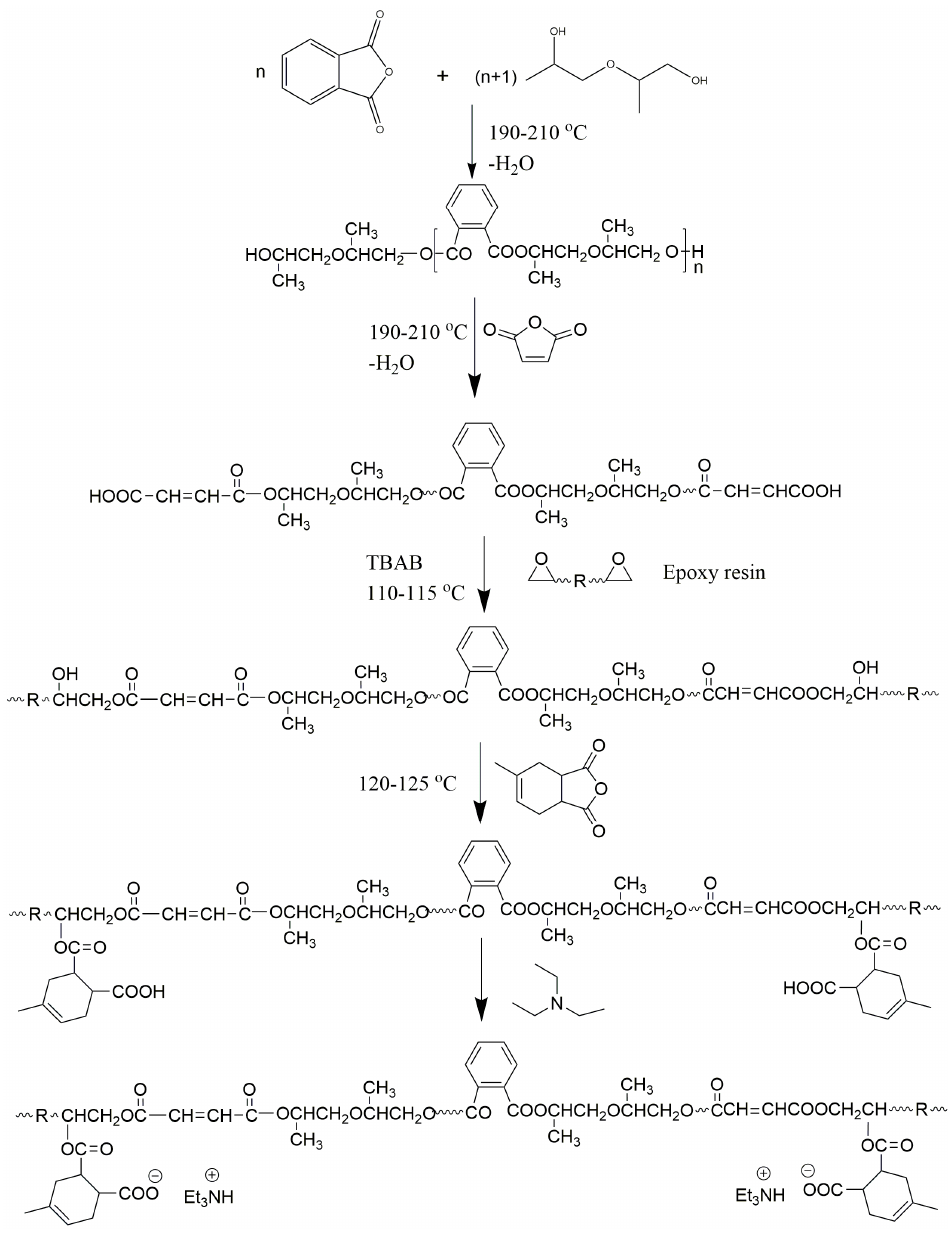
Scheme 1. Synthetic route of polyester sizing agent S1.